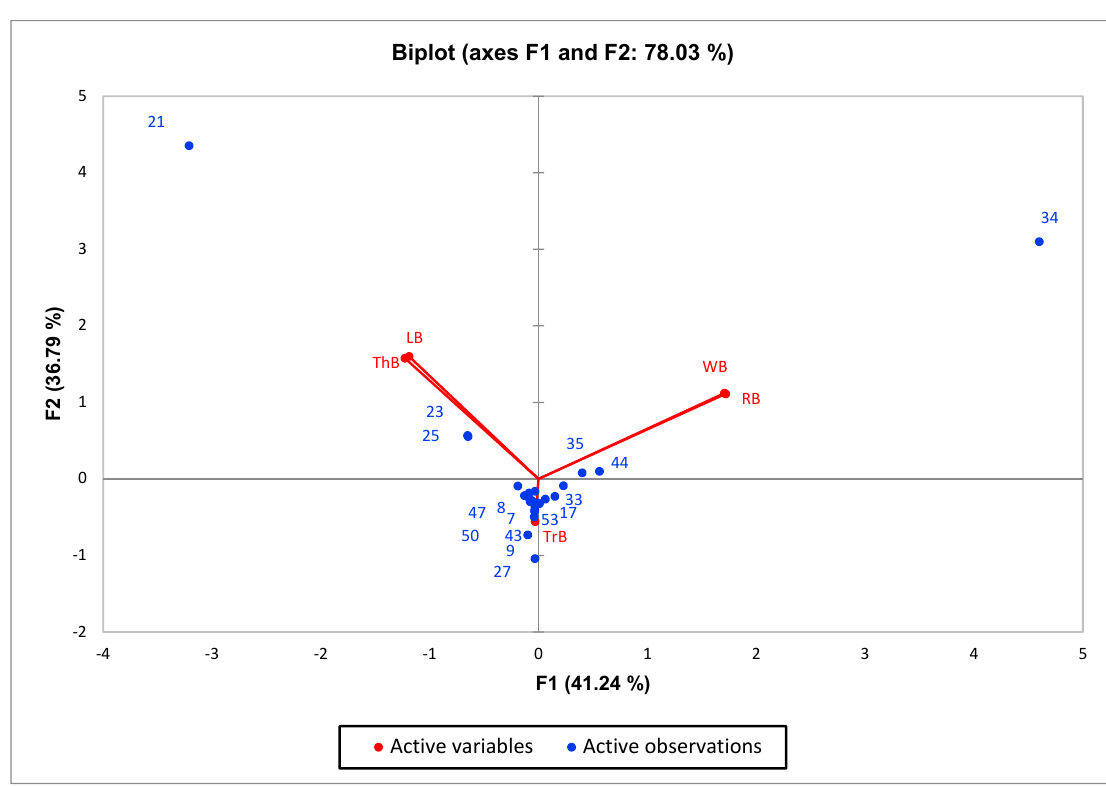
Figure 2. Principal Component Analysis (PCA) biplot illustrating the relationships among the chemical components and five Ocimum spp. Odour active compounds of 1 – 64 correspond to the code compounds in Table 3. LB = Lemon basil ( O. citriodorum ); RB = red Holy basil ( O. sanctum var. Shyama); ThB = Thai basil ( O. basilicum var. thyrsiflorum); TrB = Tree basil ( O. gratissimum ); WB = white Holy basil ( O. sanctum var. Rama). Table 4. The mean intensity values of the six attributes for the five Ocimum spp. essential oils in descriptive sensory evaluation